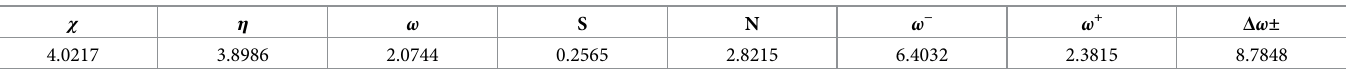
Table 4. Global Reactivity Descriptors of the Ashwagandhanolide molecular